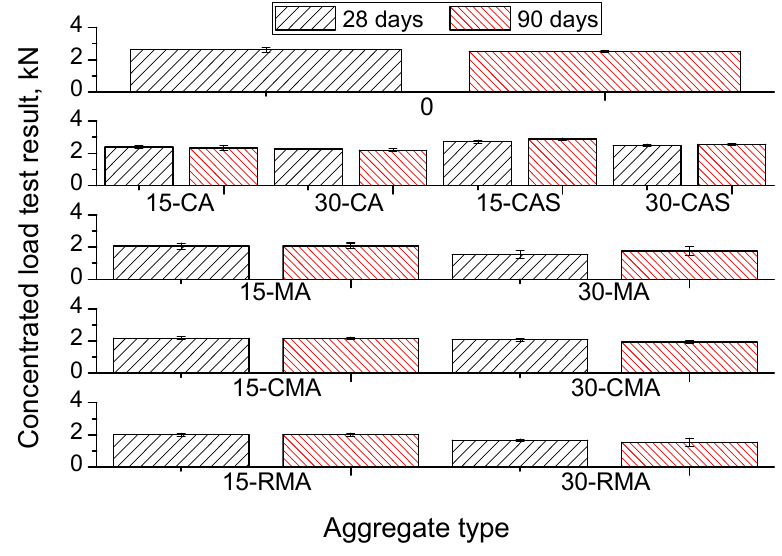
Figure 5. Results of the concentrated load test in hollow tiles, as a function of the aggregate type used.